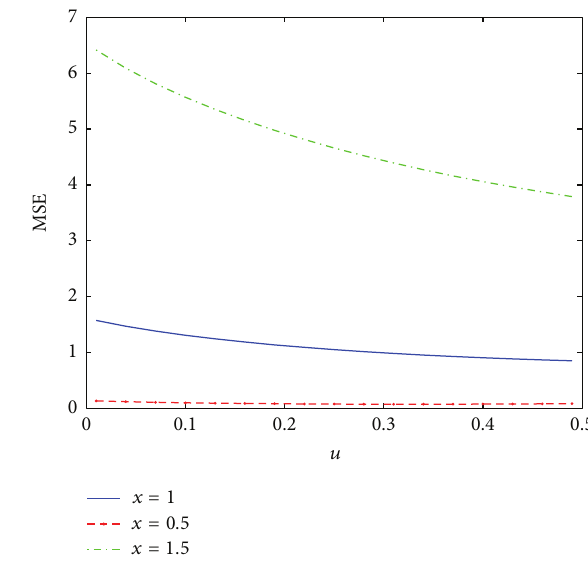
Figure 3: MSE of (13) at 𝑥 = 0.5 , 𝑥 = 1 , and 𝑥 = 1.5 .